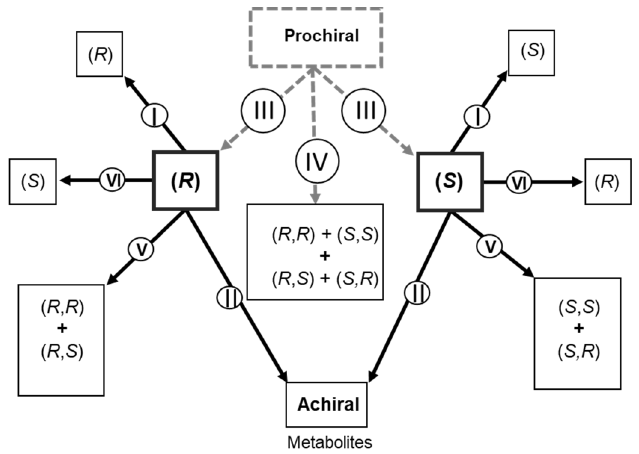
Figure 1. Types of stereoselective